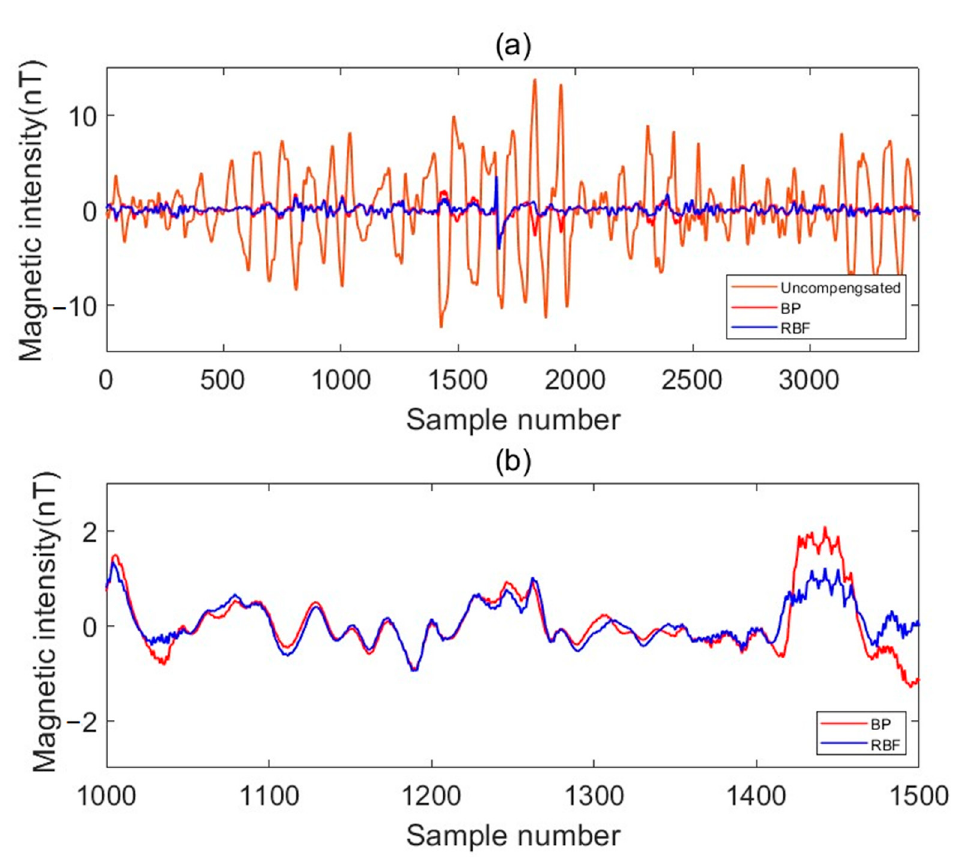
Figure 13. Flight D compensation results: ( a ) BP-ANN and BRF-ANN compensation results; and ( b ) compensation for the resulting sampling points 1000 to 1500. Table 3. Comparison of compensation results of BP-ANN and BRF-ANN.